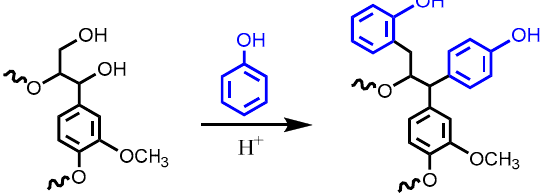
Figure 4. Acid-catalyzed phenolation of lignin. Reproduced from [28] with permission from American Chemical Society © 2020.